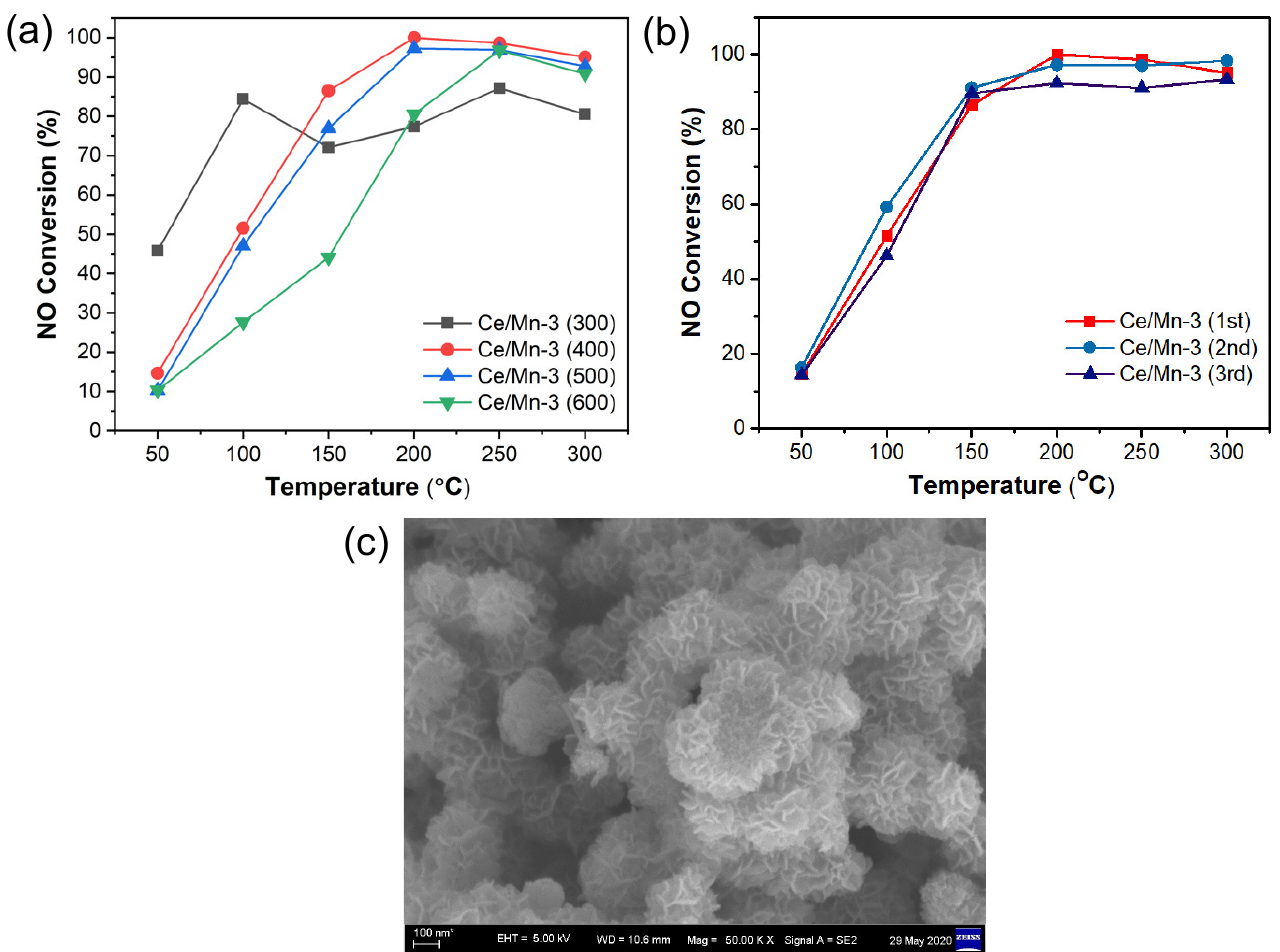
Figure 7. ( a ) NO conversion curves of the Ce/Mn-3 catalysts calcinated at different temperatures, ( b ) recycling catalytic activity tests of Ce/Mn-3 (400), and ( c ) SEM image of Ce/Mn-3 (400) after catalytic reactions.